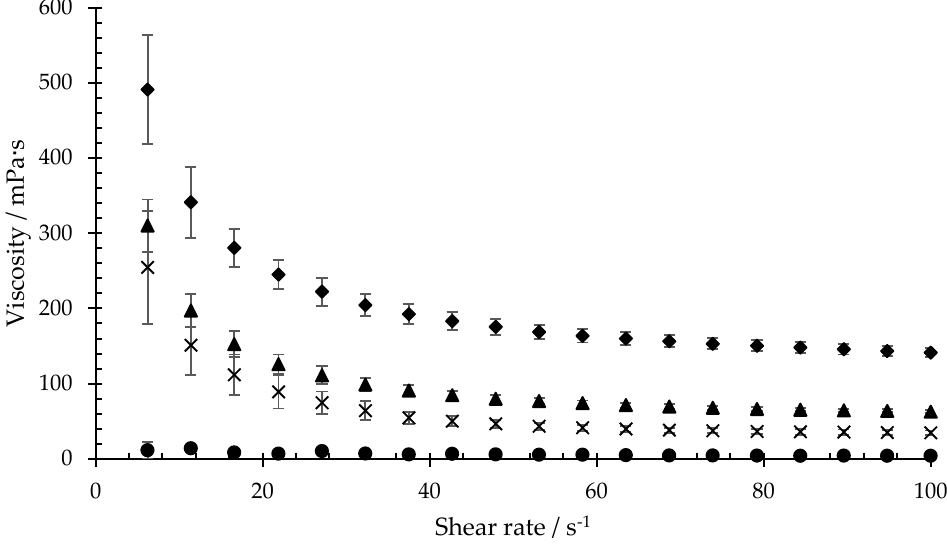
Figure 2. Viscosity of artificial saliva and isla Conc. 1-3 at a shear rate range of 1–100 s − 1 and 33 °C (19 data points, linear ramp), • artificial saliva, (cid:7) 0.23 g lozenge / mL, (cid:78) 0.115 g lozenge / mL, and × 0.077 g lozenge/mL. Mean ± standard deviation. Each sample was measured in triplicate.